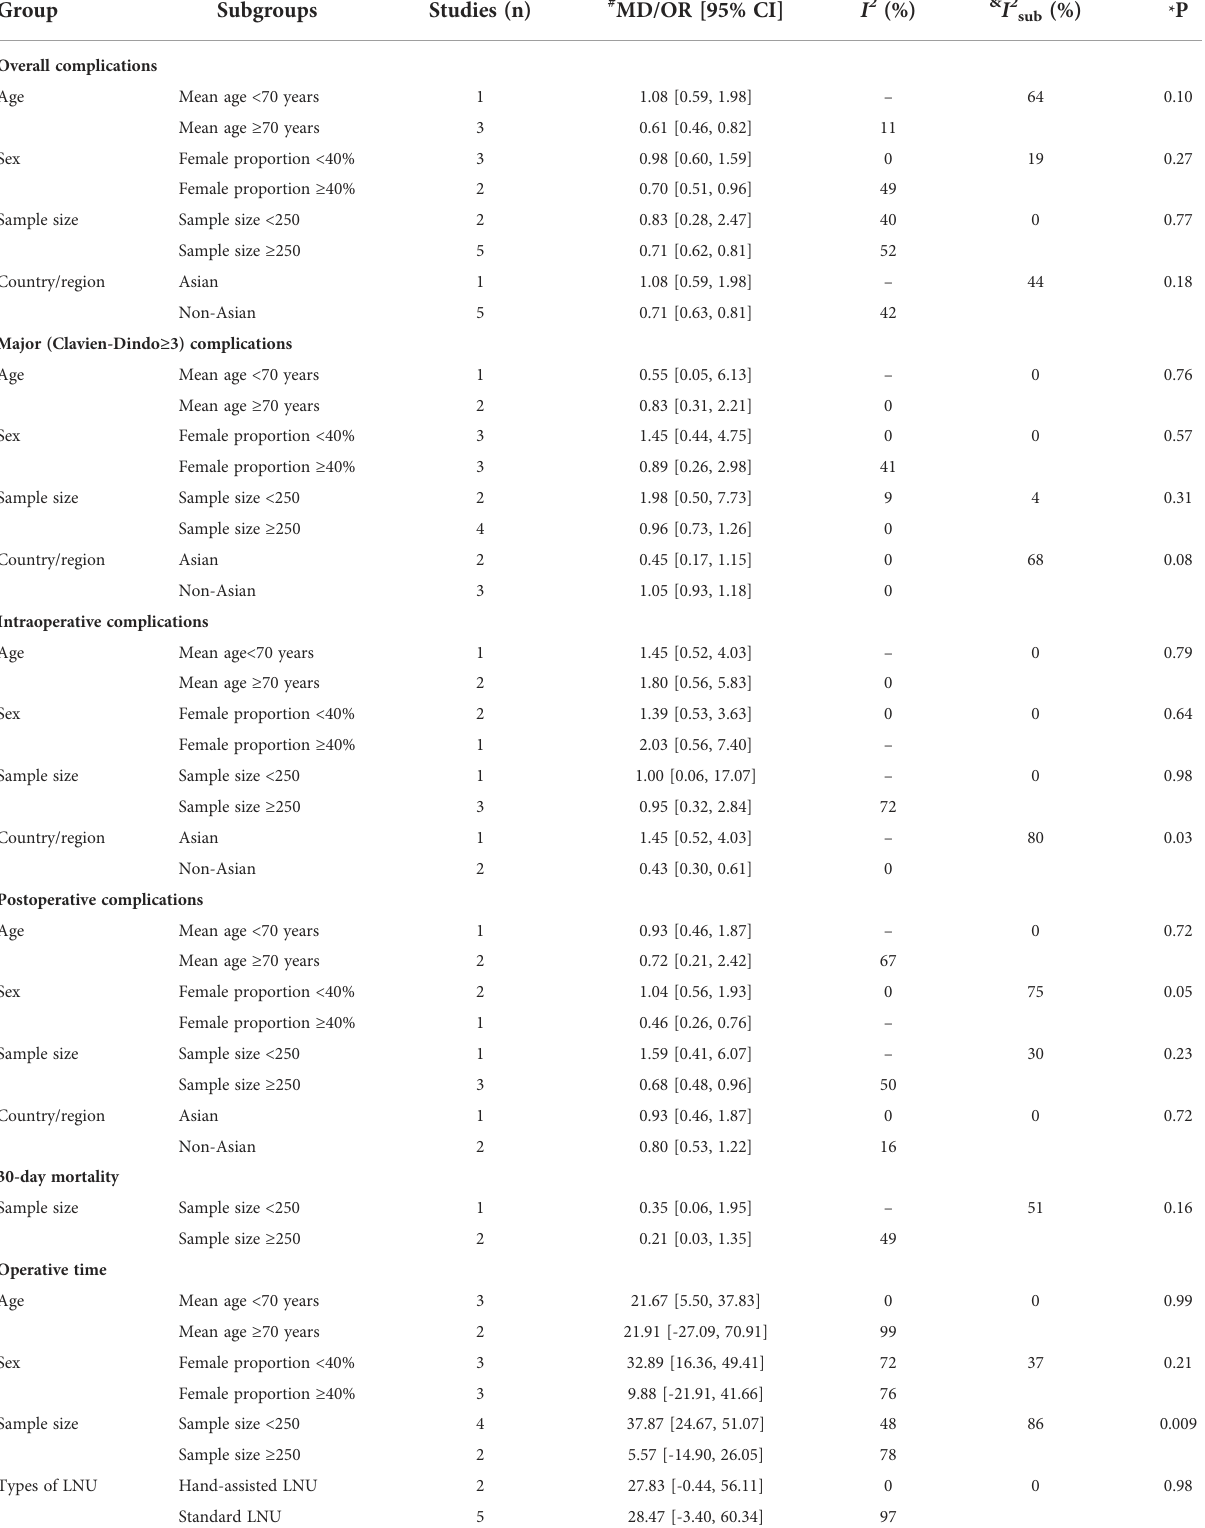
TABLE 3 Subgroup analyses and univariate meta-regression analyses of perioperative and oncologic outcomes for RANU and LNU.